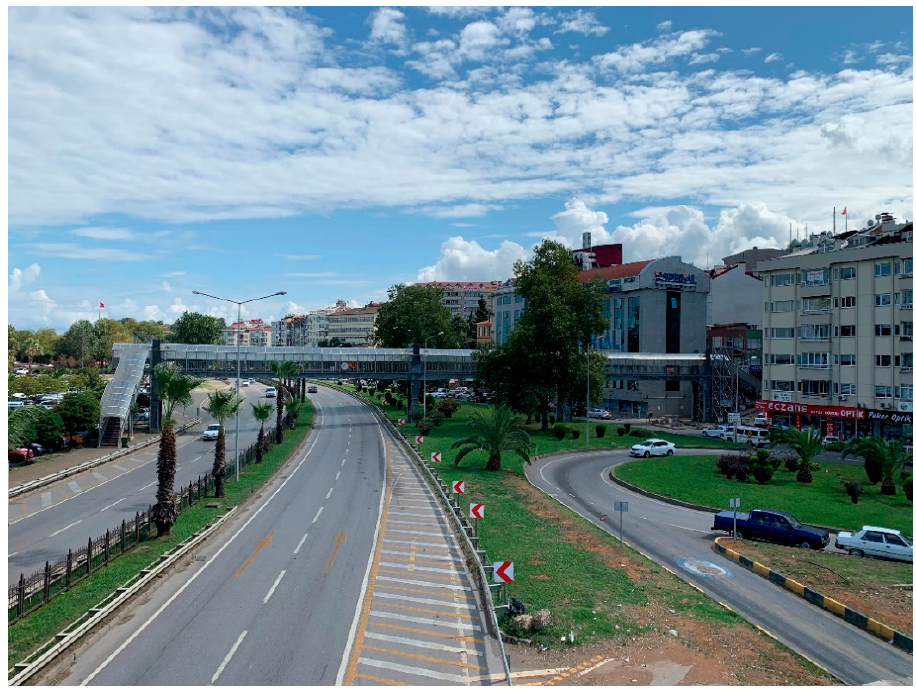
Figure 2. The view of the overpass over the road no. D010, also known as the Black Sea Coastal Highway, after construction of the roofing. Source: own study.